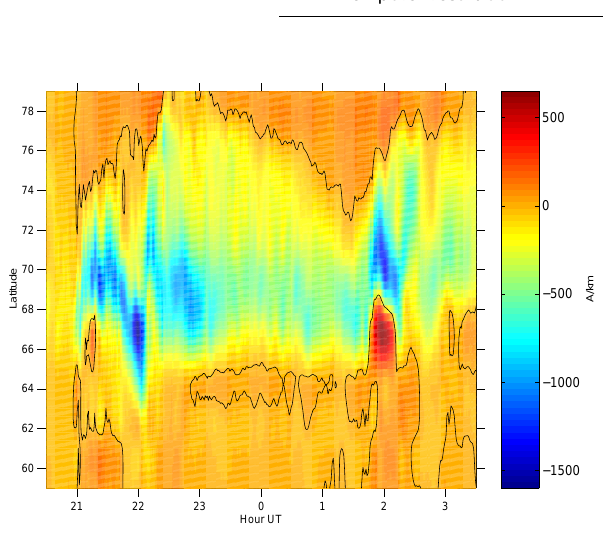
Fig. 3. The zonal component of the equivalent current across lon- gitude 25 ◦ E as calculated from IMAGE magnetometers. Eastward current is positive and the black line is the zero-current